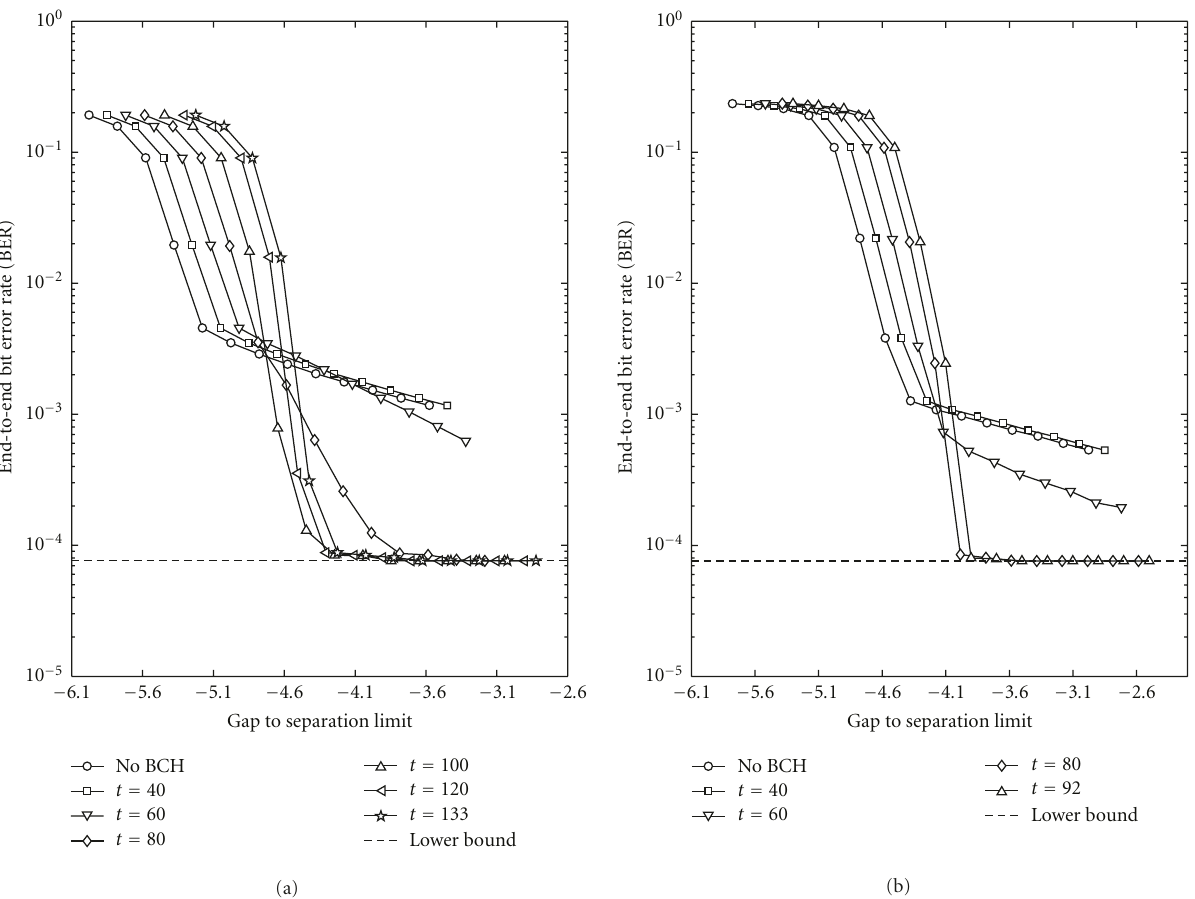
Figure 6: End-to-End BER versus gap to separation limit E b /N 0 − E ∗ b /N 0 for N = 4 sensors, di ff erent BCH codes and (a) [ d c d v ] = [10 5]; (b) [ d c d v ] = [12